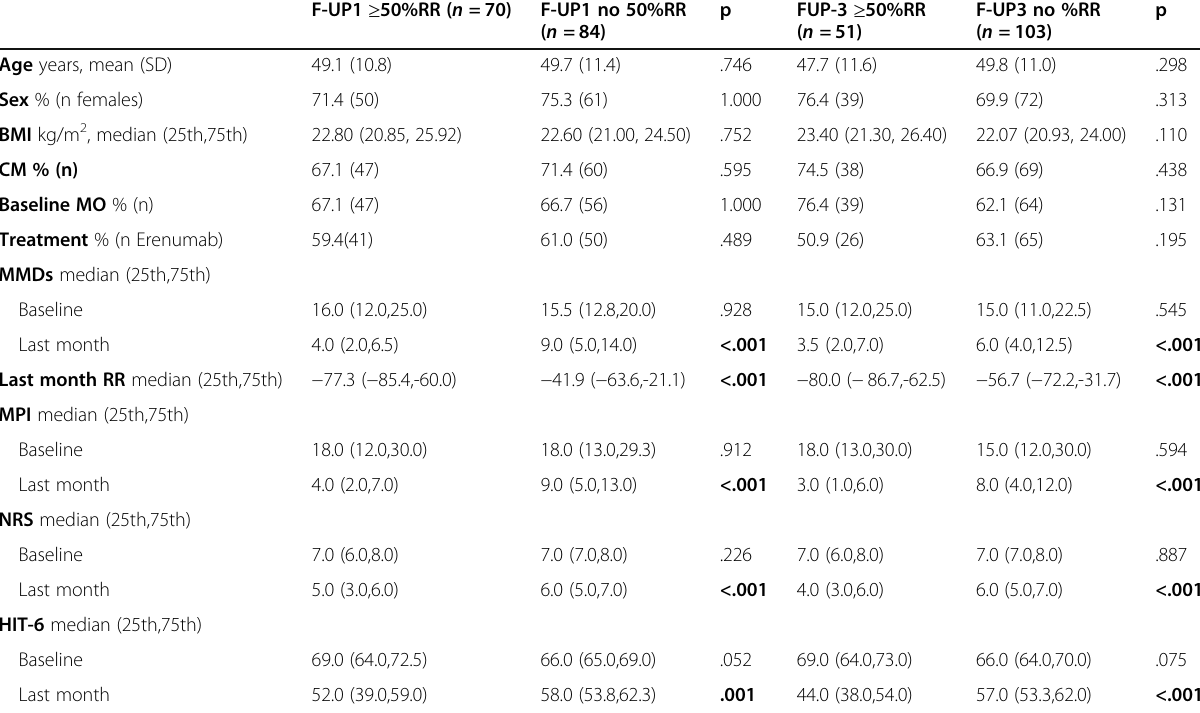
Table 2 Demographical profiles and clinical variables at evaluation times in patients with ≥ 50%RR at F-UP1 and F-UP3 (i.e. long- lasting responders) compared with non-lasting responders